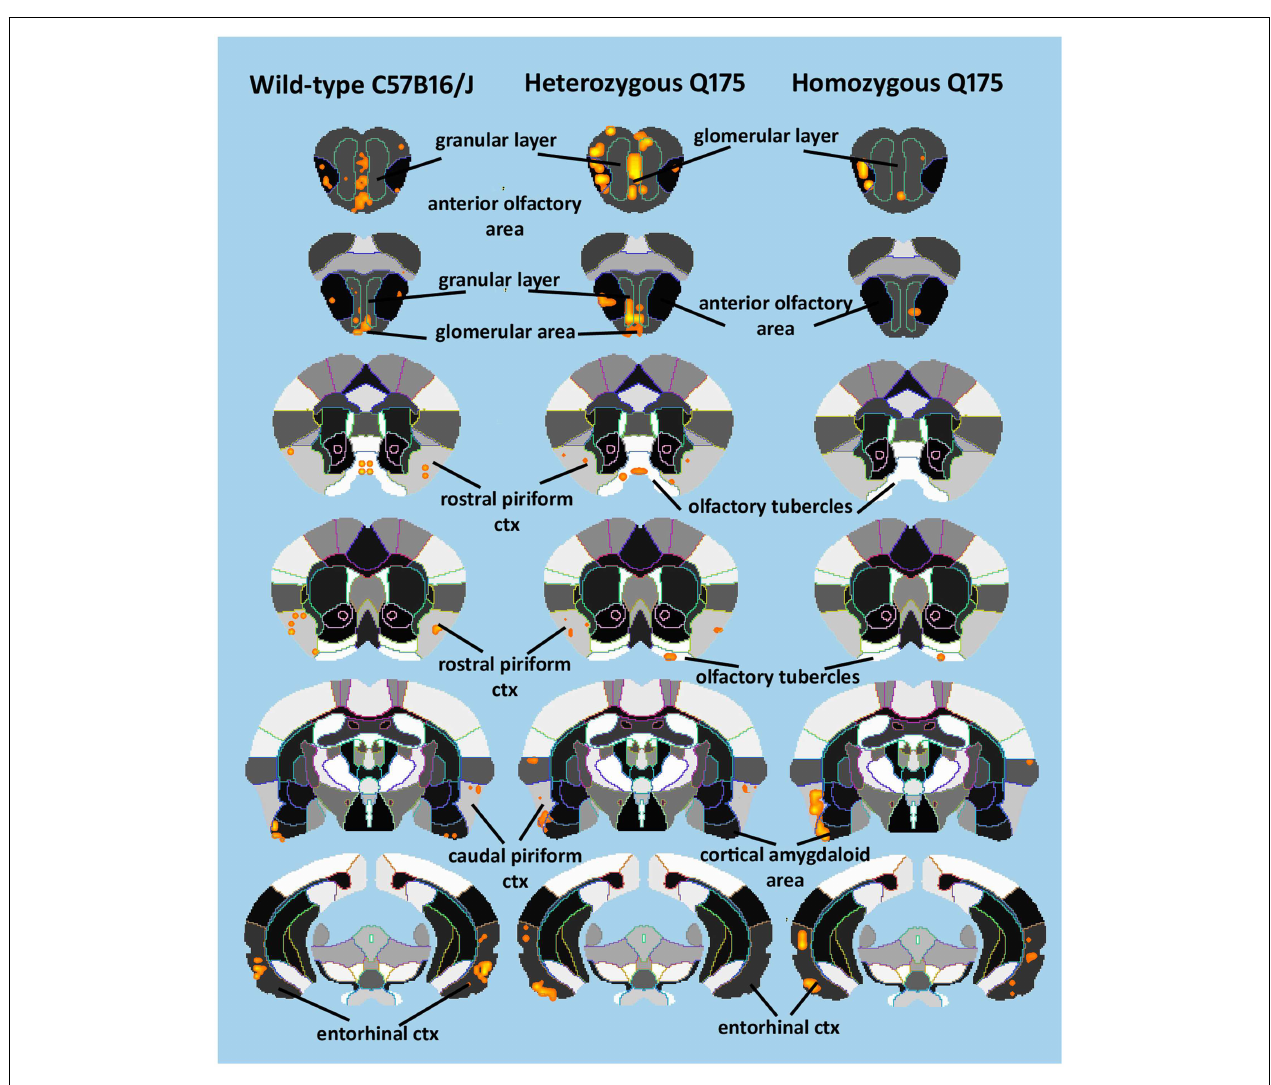
each genotype in response to the odor of almond.These are the same data shown in figure but with a 2D perspective to shown the signal location with the 3D